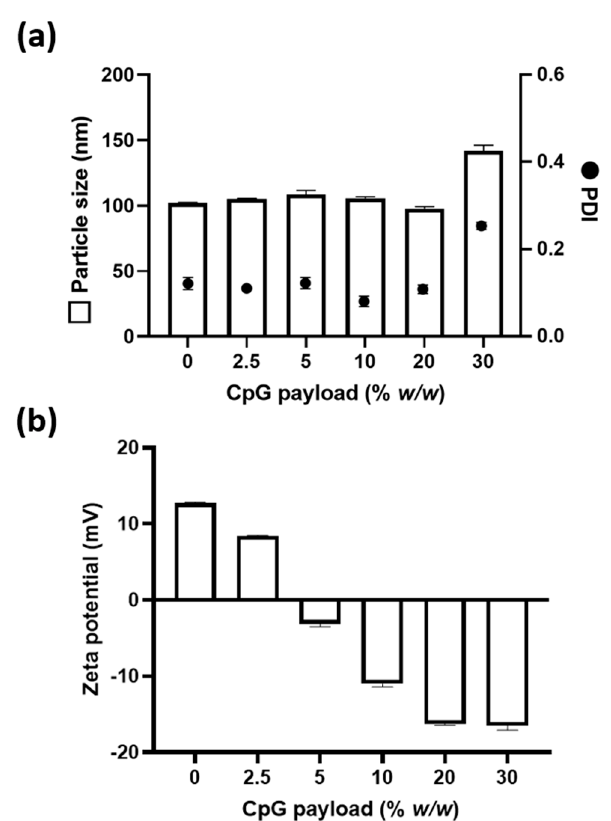
Figure 5. E ff ect of CpG payload (% w / w ) on ( a ) particle size and PDI, and ( b ) zeta potential of the amino-dextran nanoparticle following CpG adsorption. Data are presented as the mean ± S.D. ( n = 3). A change in the zeta potential of a particle is an indicator for surface binding of To quantify the amount of CpG loaded onto aDNP, the unbound CpG was removed by centrifugal filtration (MWCO 10 kDa) and the nanoparticle suspension was assayed for CpG by the